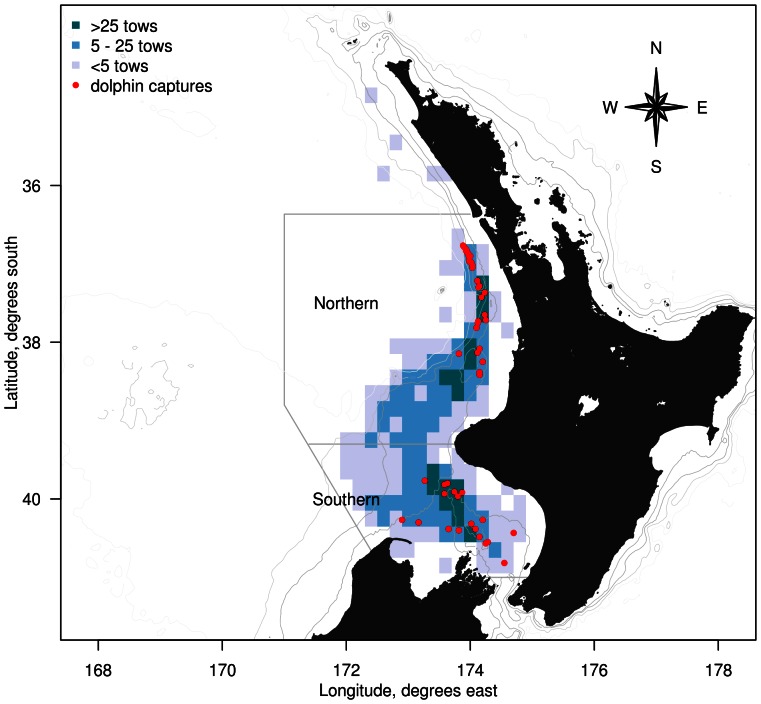
Commercial trawl effort in the west coast North Island region, New Zealand.Mean annual trawl effort (number of tows) of the commercial mackerel (Trachurus spp. and Scomber australasicus) fishery between 1 October 1995 and 30 September 2011, including locations of observed common dolphin (Delphinus delphis) captures. Also indicated are the boundaries of the area modelled for estimating common dolphin captures.